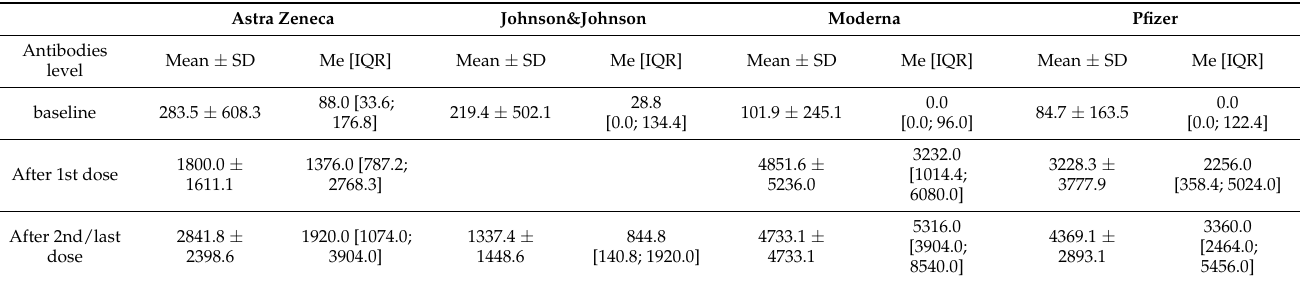
Table 5. Antibodies levels after particular SARS-CoV-2